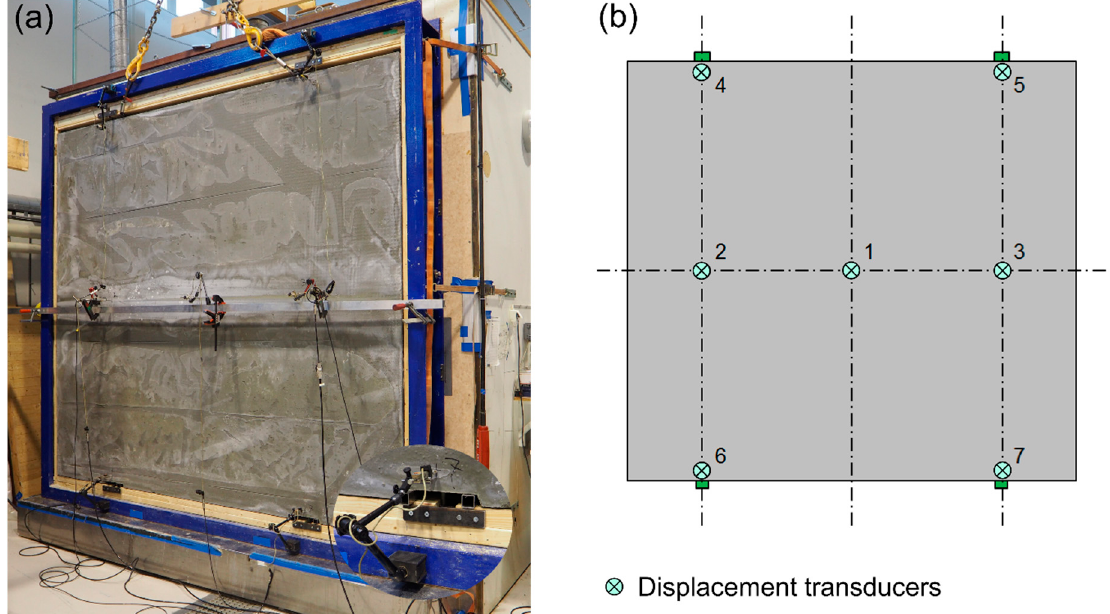
Figure 8. Photo of sandwich element mounted in the pressure test chamber ( a ) and location of displacement transducers on inner TRRPC facing ( b ).